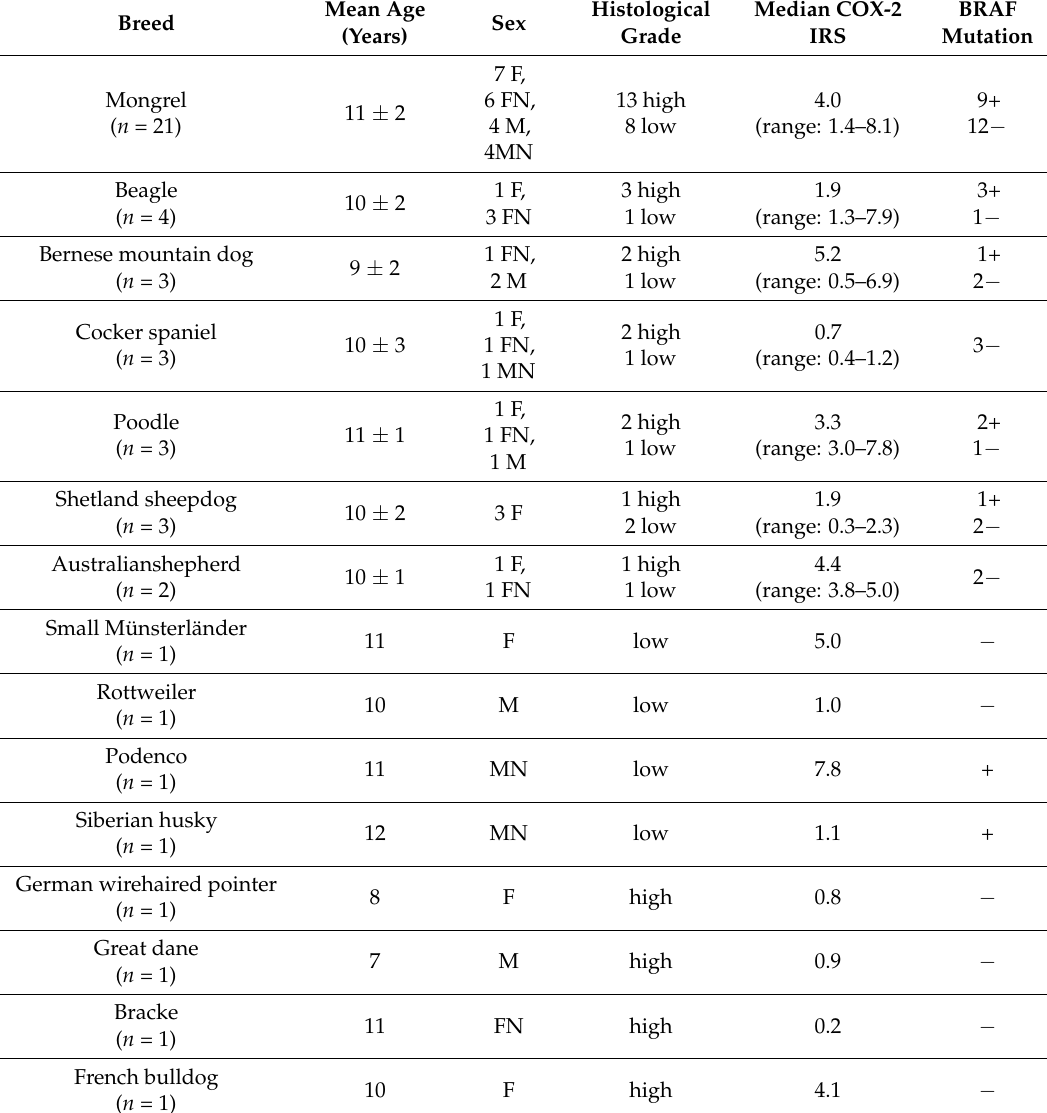
Table 2. Non-terrier breeds: signalment, histological grade, cyclooxygenase-2 expression, and BRAF mutation in transitional cell carcinoma ( n =